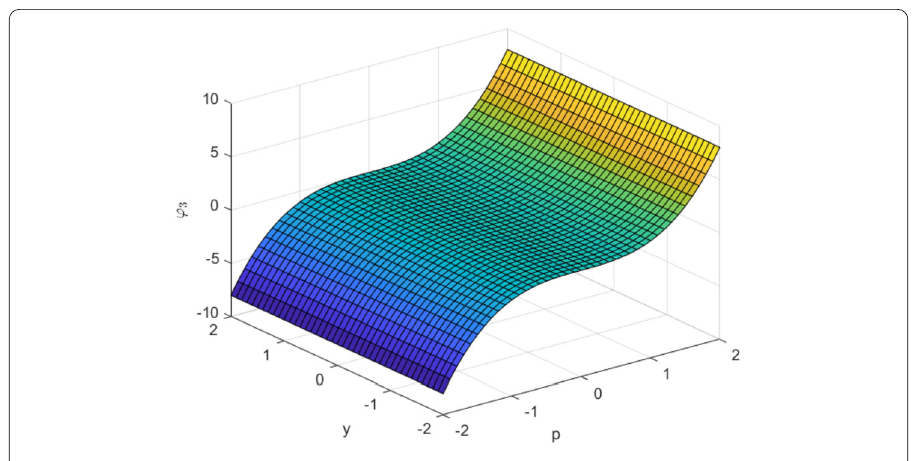
Figure 4 ϕ 3 ≥ 0 for all y ∈ [–2,2] and p